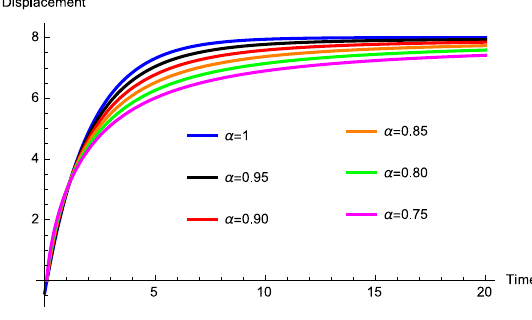
Figure 2. Numerical simulation for Equation (17) considering different values of α , arbitrarily